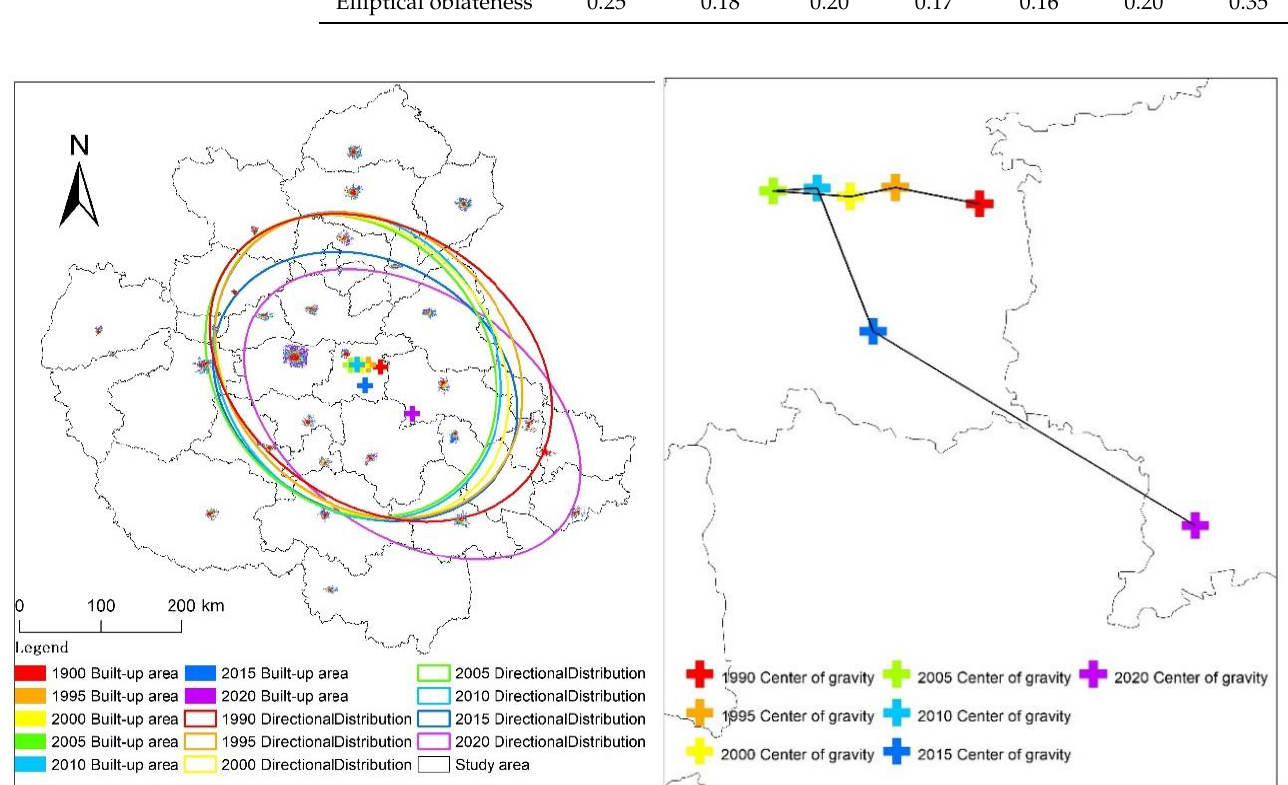
Figure 4. Standard deviation ellipse of urban built-up area and distribution of urban center of gravity. Using the average center tool in ArcGIS 10.7 (ESRI Inc., Redlands, CA, USA), the urban center of gravity of the Central Plains urban agglomeration in each period was calculated, and the results are shown in Figure 4. From the perspective of the distribution of the center of gravity of the urban space, the center of gravity of the entire region hovered in Kaifeng from 1990 to 2010. Since 2010, the urban center of gravity has continuously moved in a southeast direction, and by 2020, the urban spatial center of gravity moved to Shangqiu. The direction of movement of the center of gravity of the city is relatively consistent with the development strategy of the entire region, i.e., “expansion to the east” and “extension to the south”, which also reflects the effect of the regional development